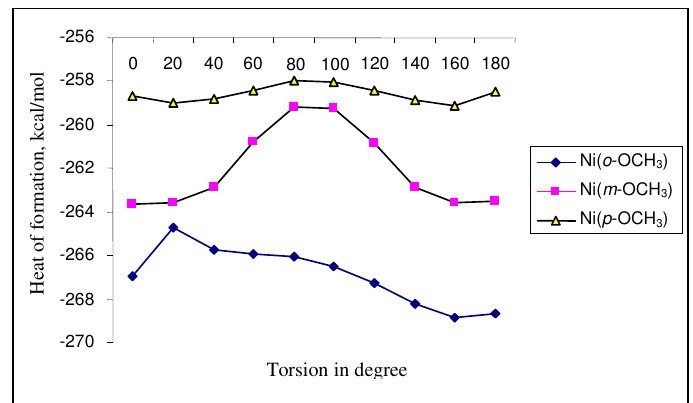
Figure 4. Torsion curves of un-substituted, ortho, meta and para- methoxyl Ni[C H CON ] 32+ . 6 7 2